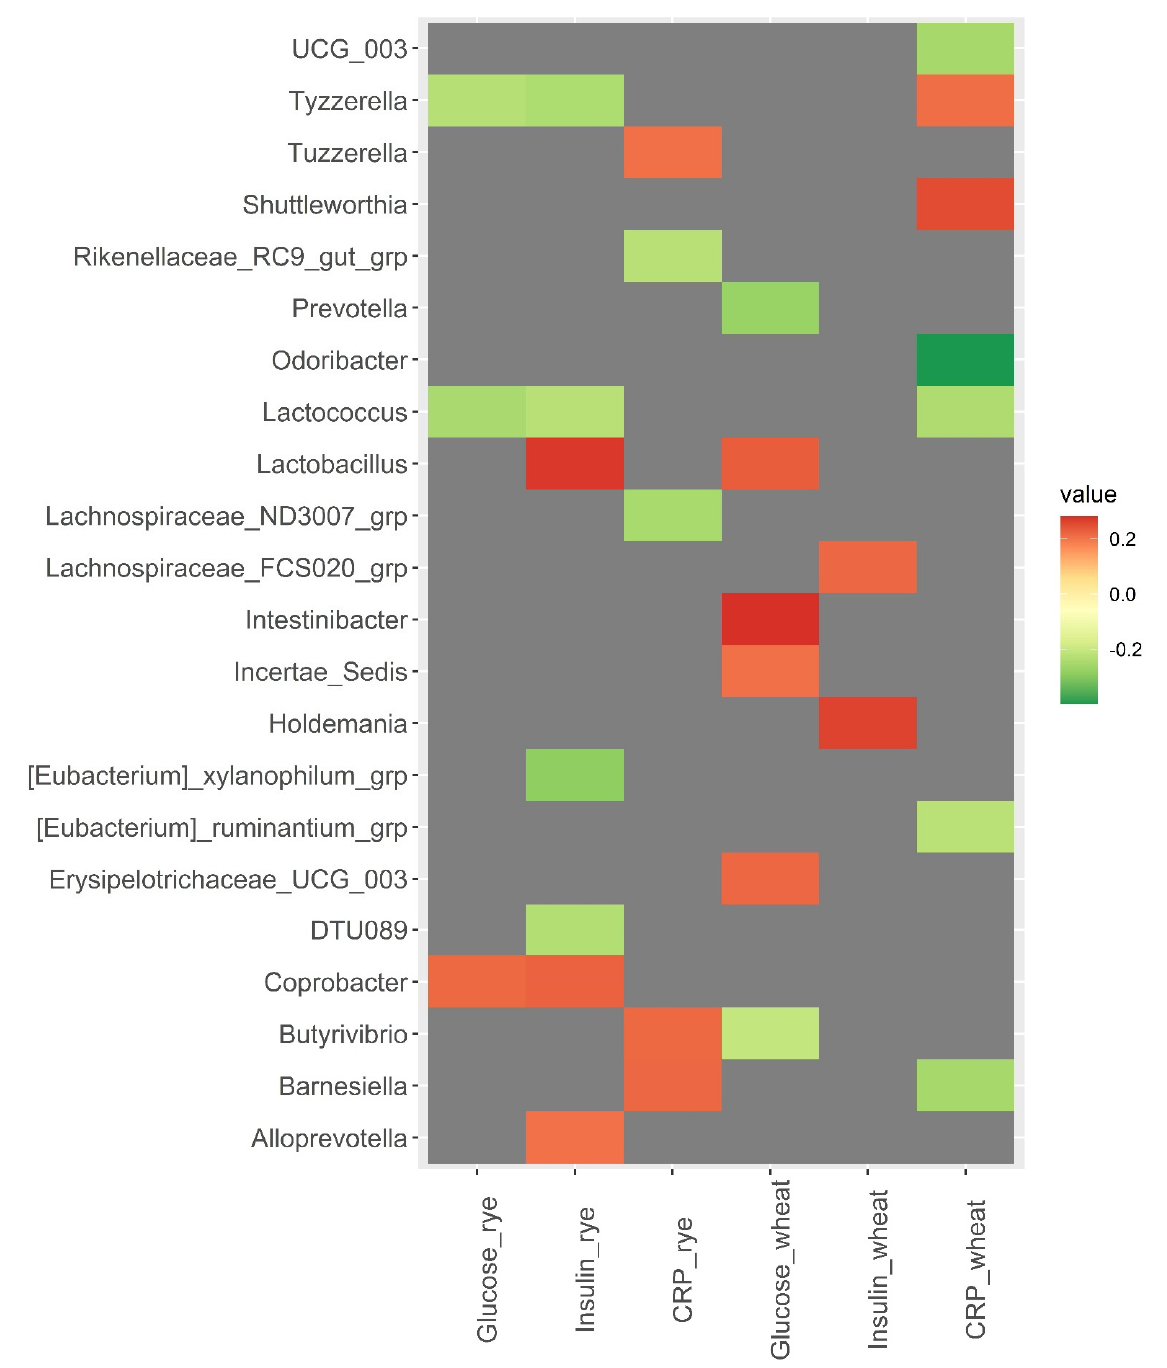
Figure 3. Heatmaps of correlations (Spearman’s rho ) between bacterial abundance at baseline and changes in glucose, insulin, and C-reactive protein over 12 weeks within the wheat group and the rye group. Only significant correlations with Spearman’s rho ≥ |0.200| are included in the heatmap, while correlations for all 110 bacteria are shown in Supplementary File S2. Abbreviations: CRP, C-reactive protein.